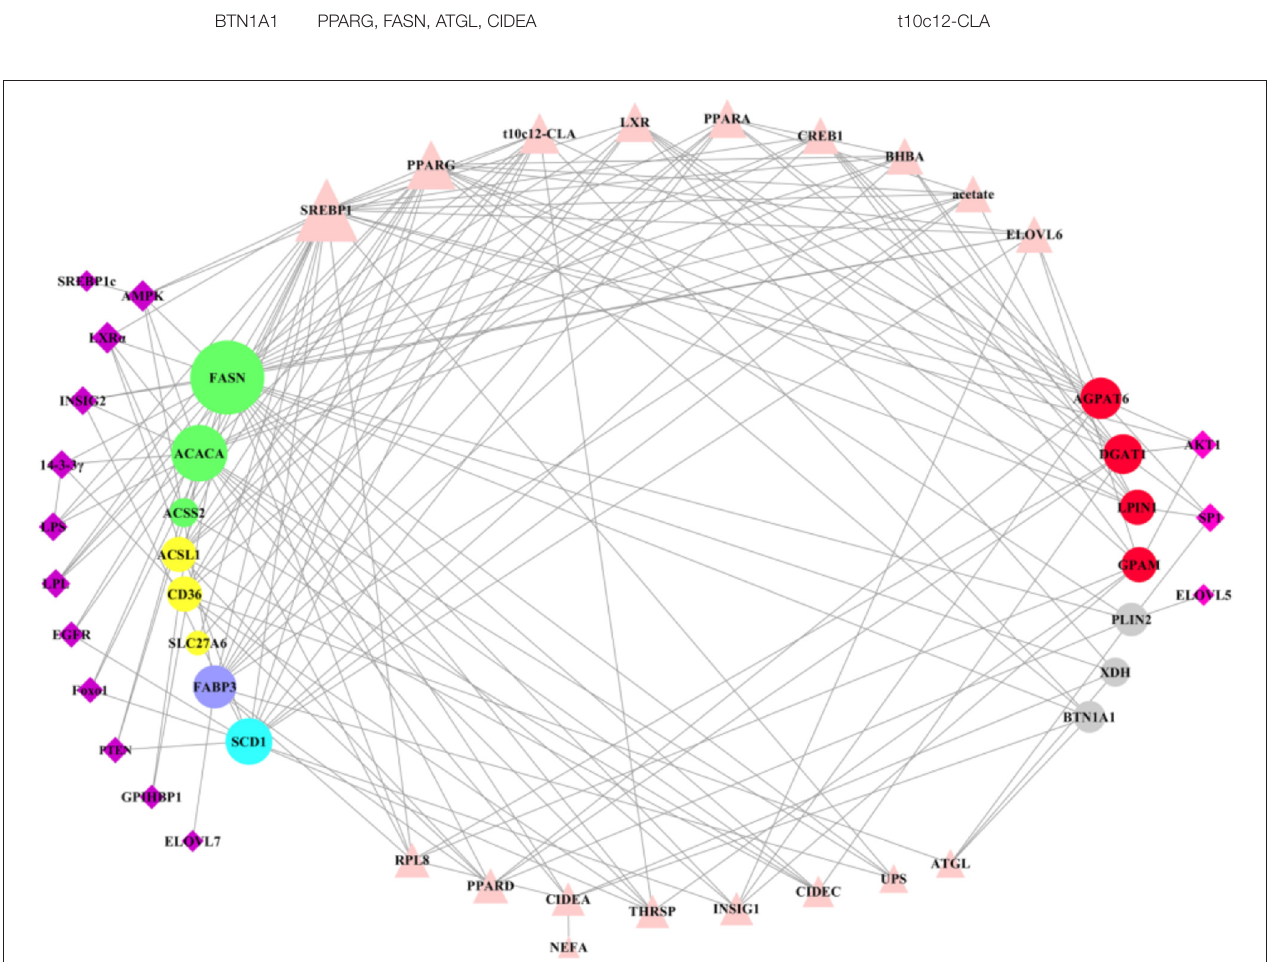
FIGURE 7 | Overall regulatory network of key genes in milk fat synthesis in ruminants. The circle represents the key genes in milk fat synthesis in ruminants, of which the left is the key genes in de novo milk fat synthesis, LCFA uptake, FA transport and desaturation, and the right is the key genes in TAG synthesis and lipid droplet secretion. The quadrilateral represents the regulatory factors that regulate the key genes on the left and right sides of milk fat synthesis, respectively. Triangles represent the key factors that play a regulatory role in milk fat synthesis. The larger the figure, the more complex the regulatory relationship.